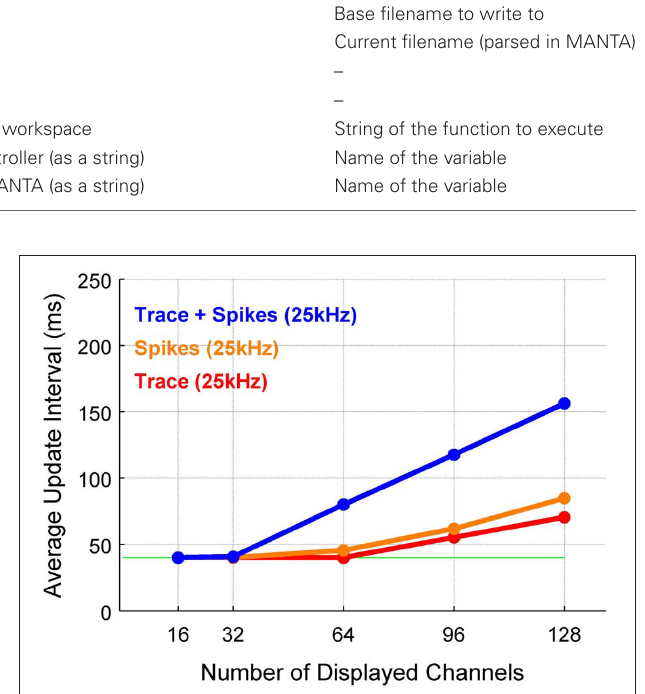
FIGURE 4 | The update interval remains usable up to a high number of channels. The time between successive updates of the display depends on computer hardware, the analyses displayed and the parameters of the acquisition. The dependence of update rate on the number of channels is close to linear, only flattened at the lower limit by the maximum frame rate (25Hz = 40ms). The update interval is strongly influenced by whether only the raw trace (red), only spikes (red), or both are displayed (blue). The dependence on the sampling rate was only slight, since only a fraction of the points are displayed in each step (data not